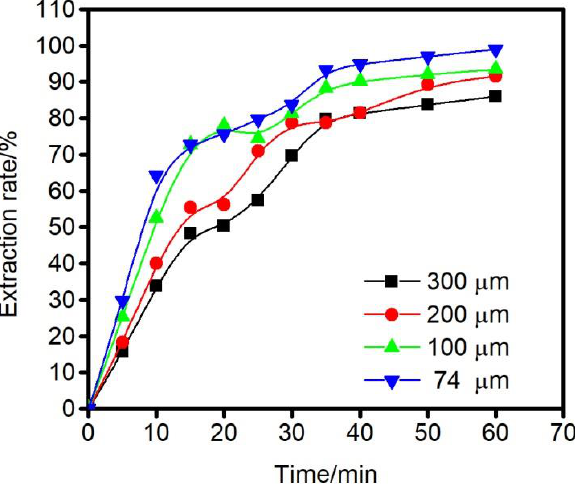
Figure 7. Effect of various particle sizes on iron removal rate over time Figure 5. TG-DSC analysis of the NH 4 Cl and EBFS mixture